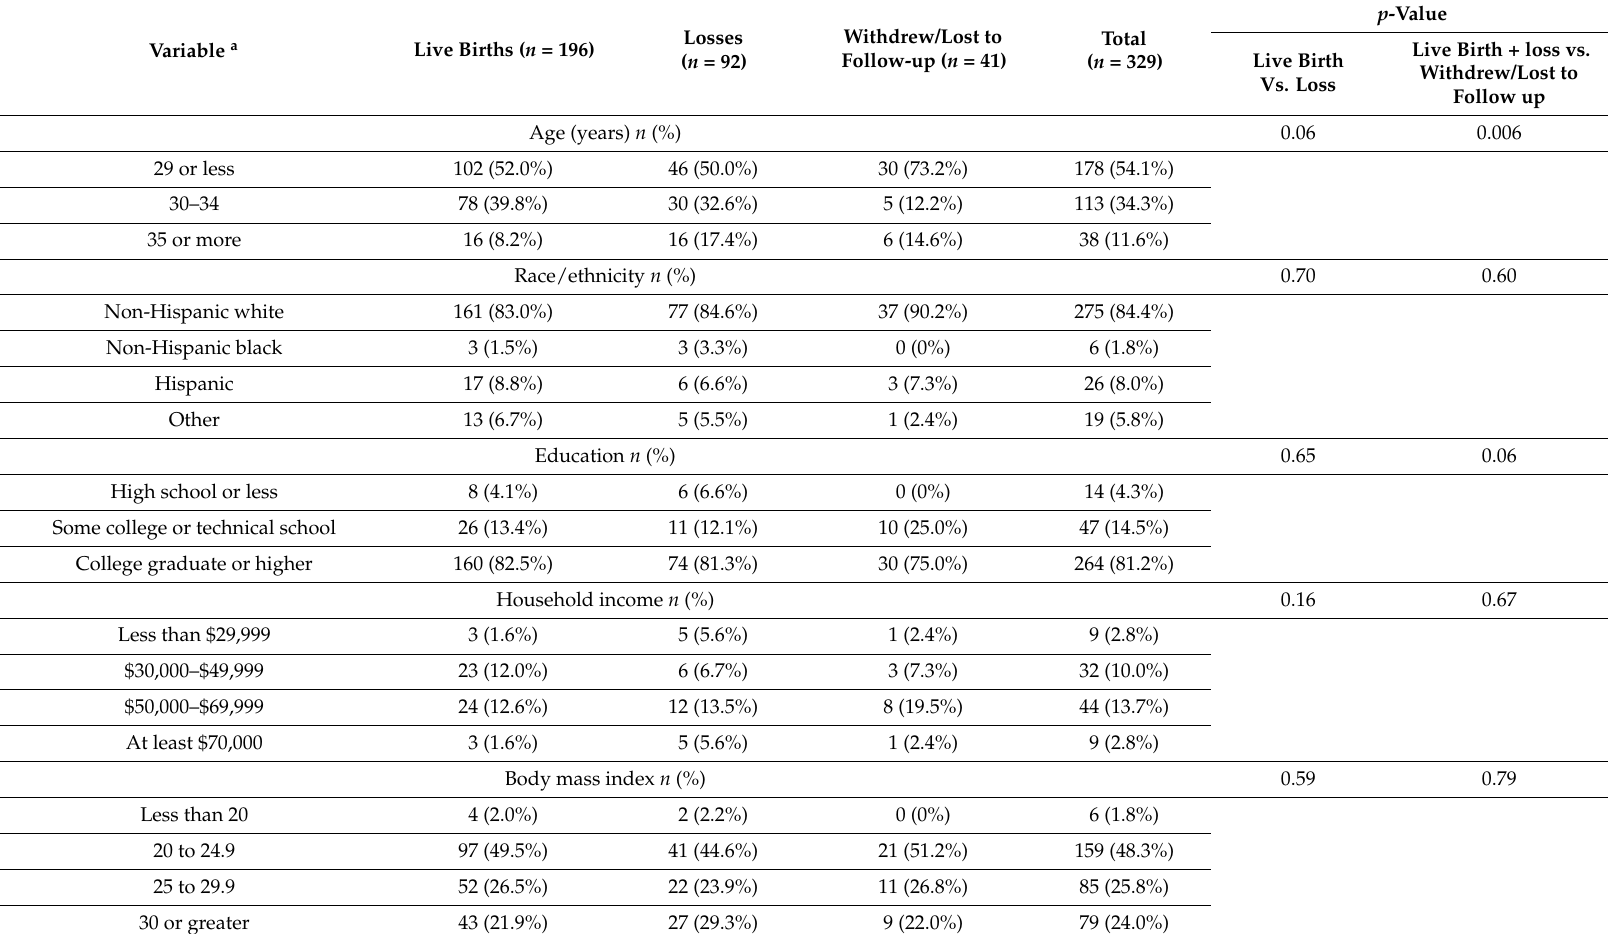
Table 1. Characteristics of women becoming pregnant by study outcome ( n =